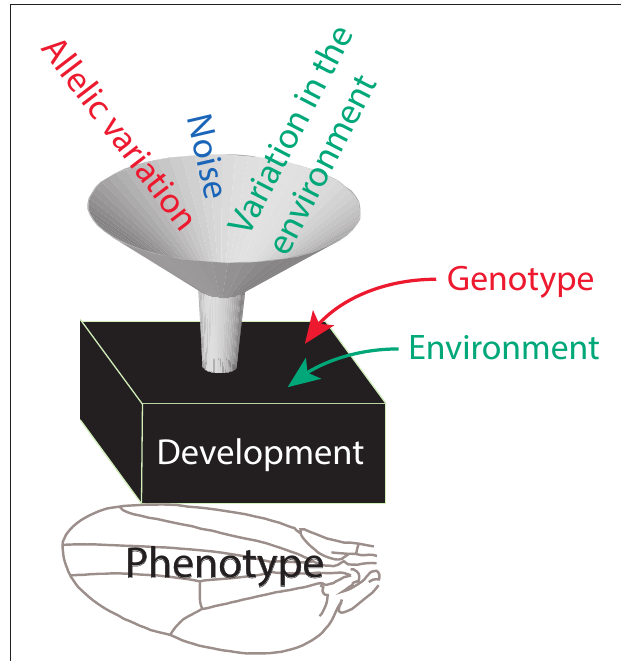
FIGURE 1 | A cartoon view of how the developmental system mediates the effects of different inputs of variation to produce phenotypic variation. Note that genes and the environment have two possible roles each: as direct inputs of variation (in the funnel), when individuals differ in their genotypes or in the environments they experience and may differ in their phenotype as a result, and also as factors influencing the state of the developmental system (arrows from the right) and therefore possibly how it responds to the direct